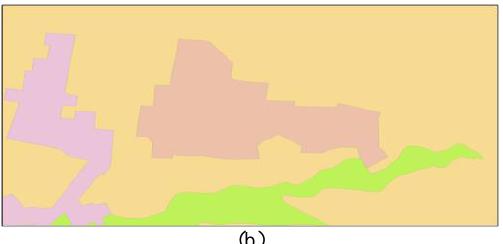
Figure 1. Merger of land-cover data based on the global optimum. (a) Original land-cover areas; (b) merging results.